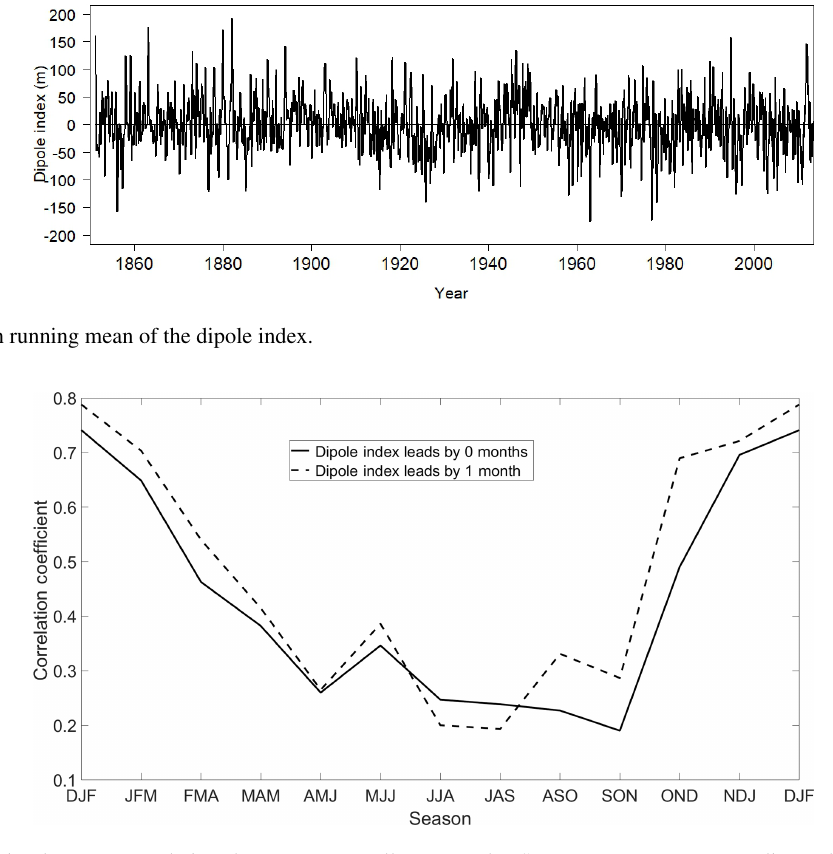
Fig. 7 is between the NDJ dipole index and DJF LIS water temperature